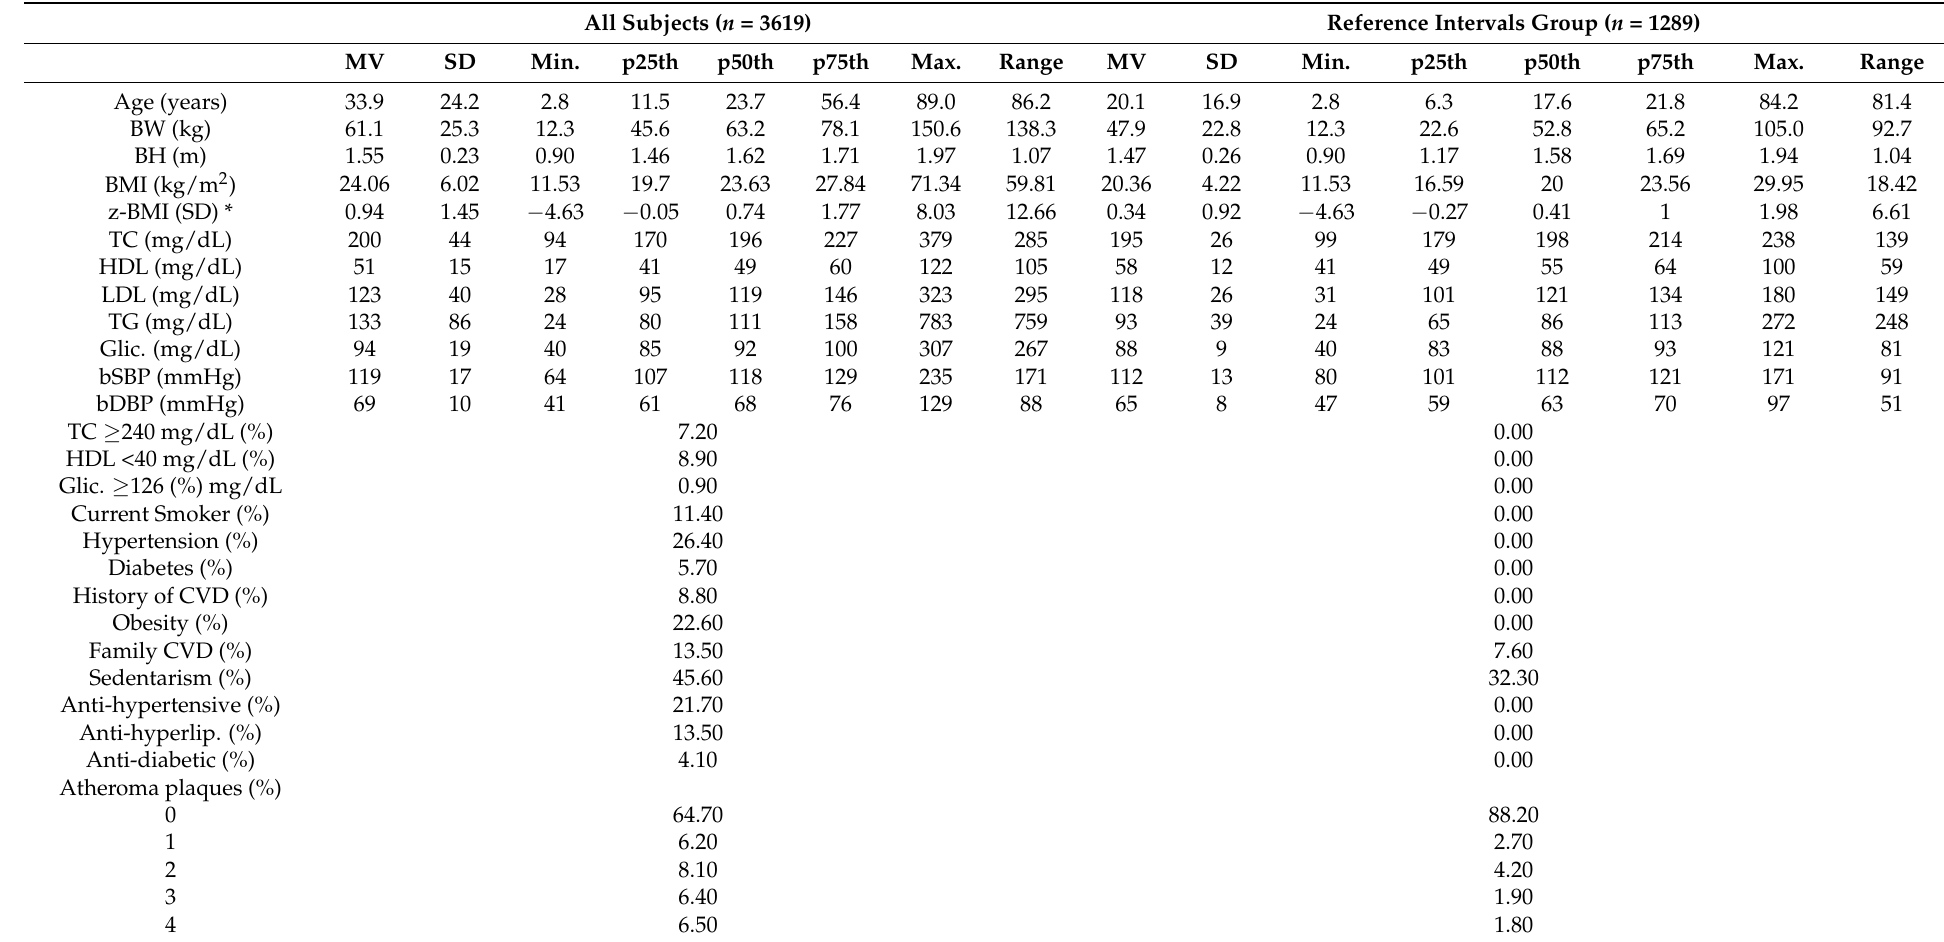
Table 2. Subjects demographic, anthropometric and clinical